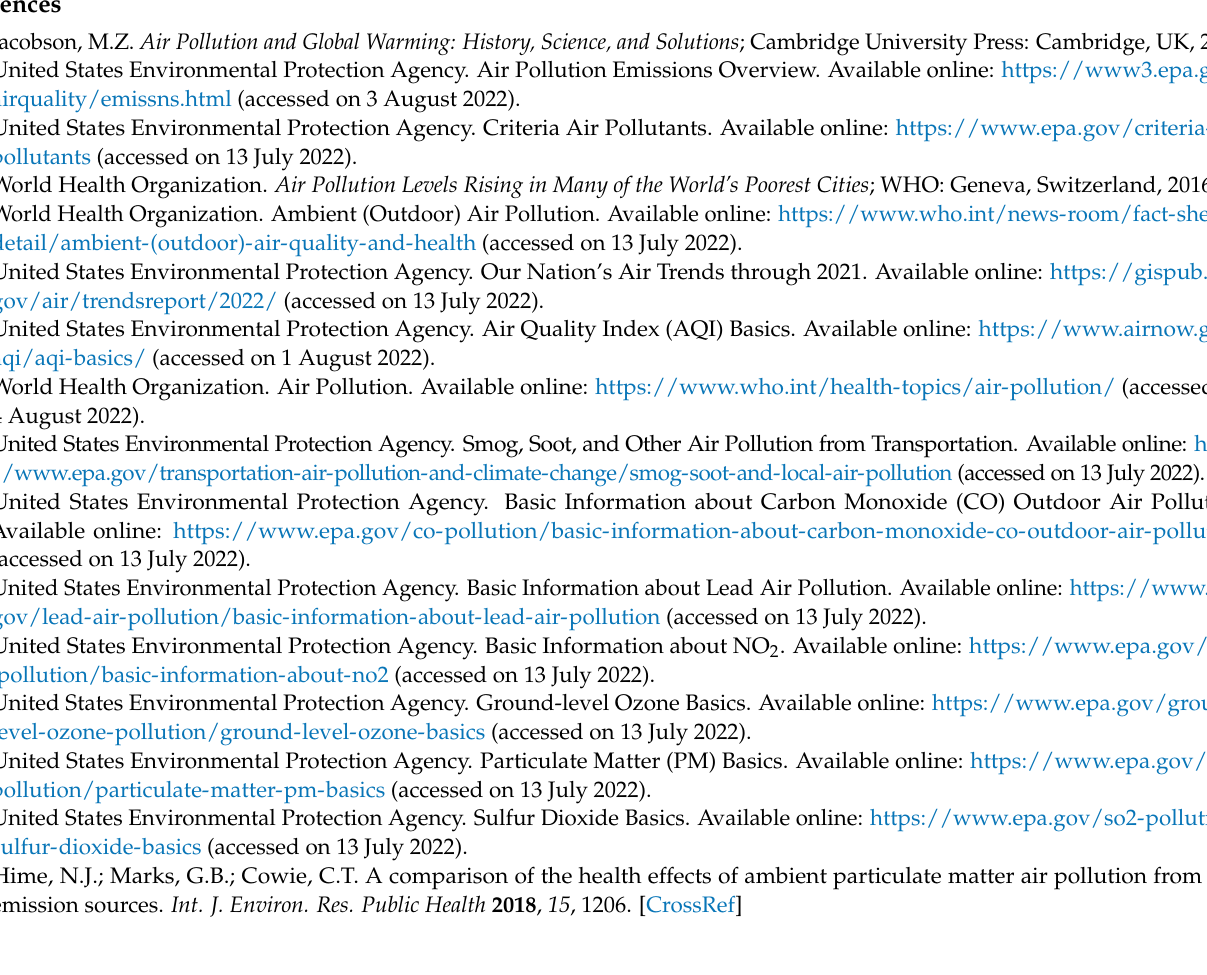
Figure A18. Bonneville Elementary School observation form.